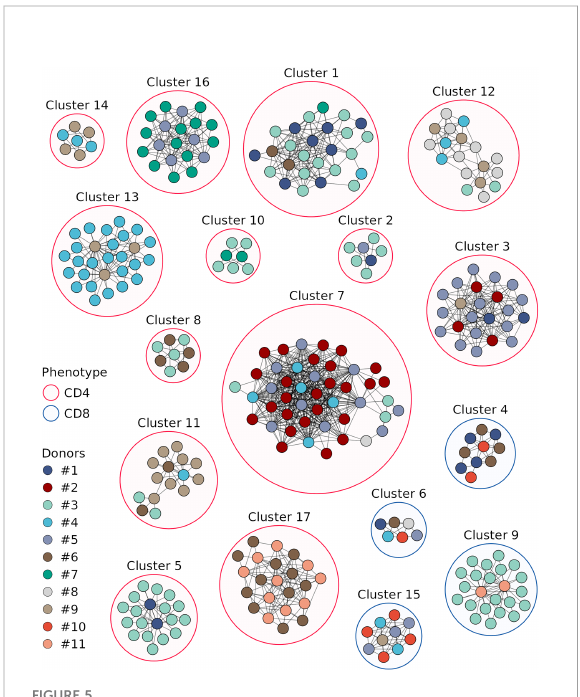
FIGURE 5 Sequence similarity networks for the responded clonotypes from different donors. Each vertex corresponds to a unique TCR b clonotype. Edges connect clonotypes with one or no mismatches in CDR3 amino acid sequences and identical V and J segments; only edges between clonotypes of different donors are shown. Color of the area around clusters indicates CD4 + (red) or CD8 + (blue) phenotypes of T cell clones in the cluster. Only clonotypes with similarity to at least 2 clonotypes of other donors and clusters with 6 or more clonotypes are